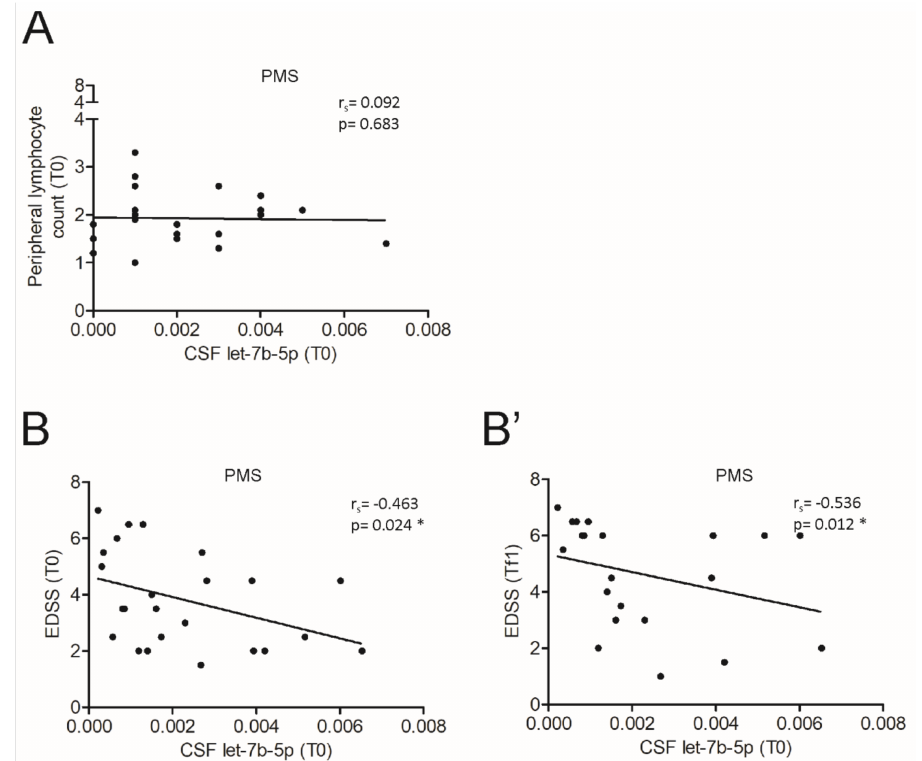
Figure 6. The CSF level of let-7b-5p correlates with disease severity in MS progressive phase. ( A ) Correlation plot between let-7b-5p levels and the count of peripheral T cells of PMS patients (n = 22, A ) at T0. ( B , B’ ) Correlation plot between let-7b-5p levels and EDSS of PMS patients at T0 (n = 24, B ) and after a follow-up period ((Tf1), n = 21, B’ ). A negative correlation was observed at both T0 (Spearman’s correlation, Spearman’s r = − 0.463, * p < 0.05) and Tf1 (Spearman’s correlation, Spearman’s r = − 0.536, * p < 0.05). Table 4. Correlation between the levels of let-7b-5p and biochemical factors circulating in the CSF of patients with PMS at T0. corr p Value p Adjusted Cytokines IL5 0.567 0.004 0.035 Cluster 1 Chemokines Rantes 0.628 0.001 0.028 Growth Factors G_CSF 0.587 0.003